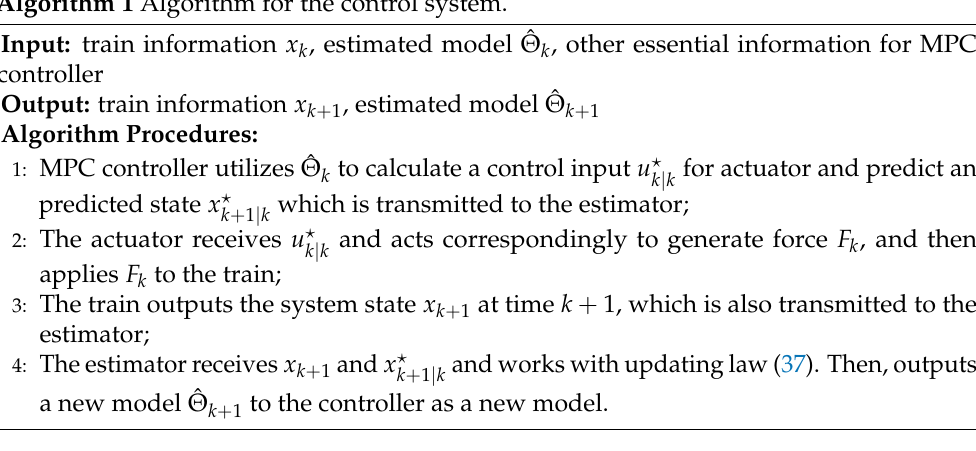
Algorithm 1 Algorithm for the control system.